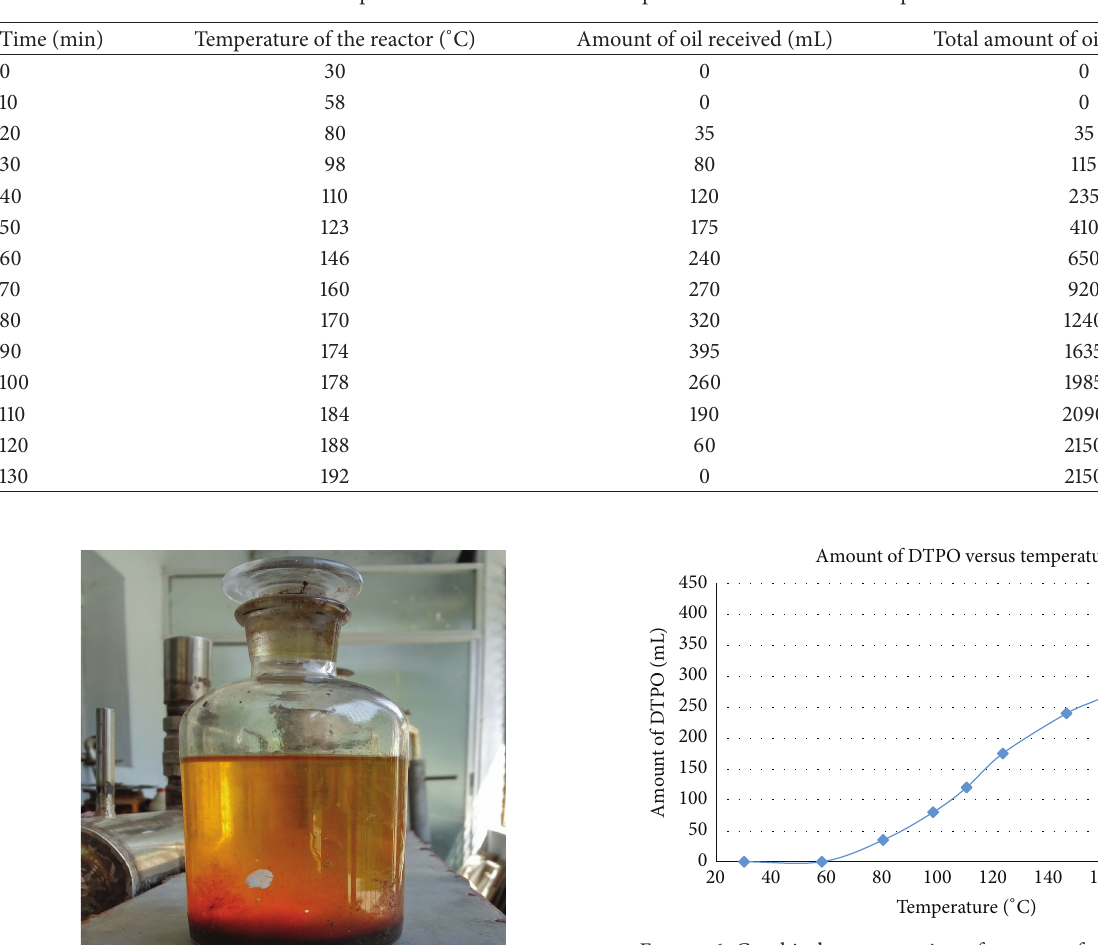
Figure 6: Graphical representation of amount of oil received with different